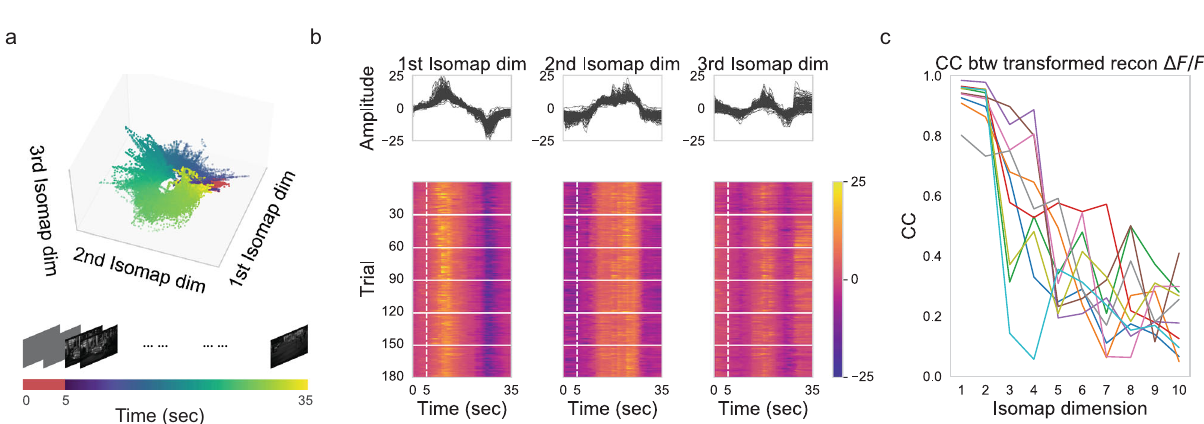
Fig. 4 Stable manifolds exist in unstable population activity. a Three-dimensional neural trajectories extracted from reconstructed (denoised) Δ F / F populational activity across weeks from the example imaging fi eld using Isomap. Each dot represents instantaneous population activity. The color of the dot indicates the corresponding time in the trial. b Upper panels: neural trajectories along the fi rst three Isomap dimensions were plotted separately. Lower panels: the same data as shown in the upper panels were displayed as heatmaps to show the trial-to-trial variability clearly. c Correlation coef fi cients (CC) between transformed reconstructed Δ F / F (neural trajectories) across trials along each Isomap dimension are plotted for all ten imaging fi elds. Different colors denote different imaging fi